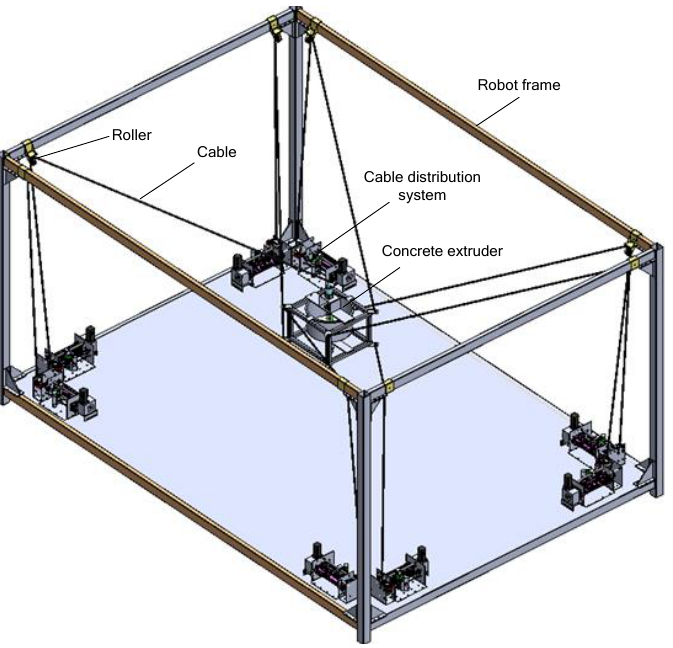
Figure 13. Cable robot and concrete extruder.